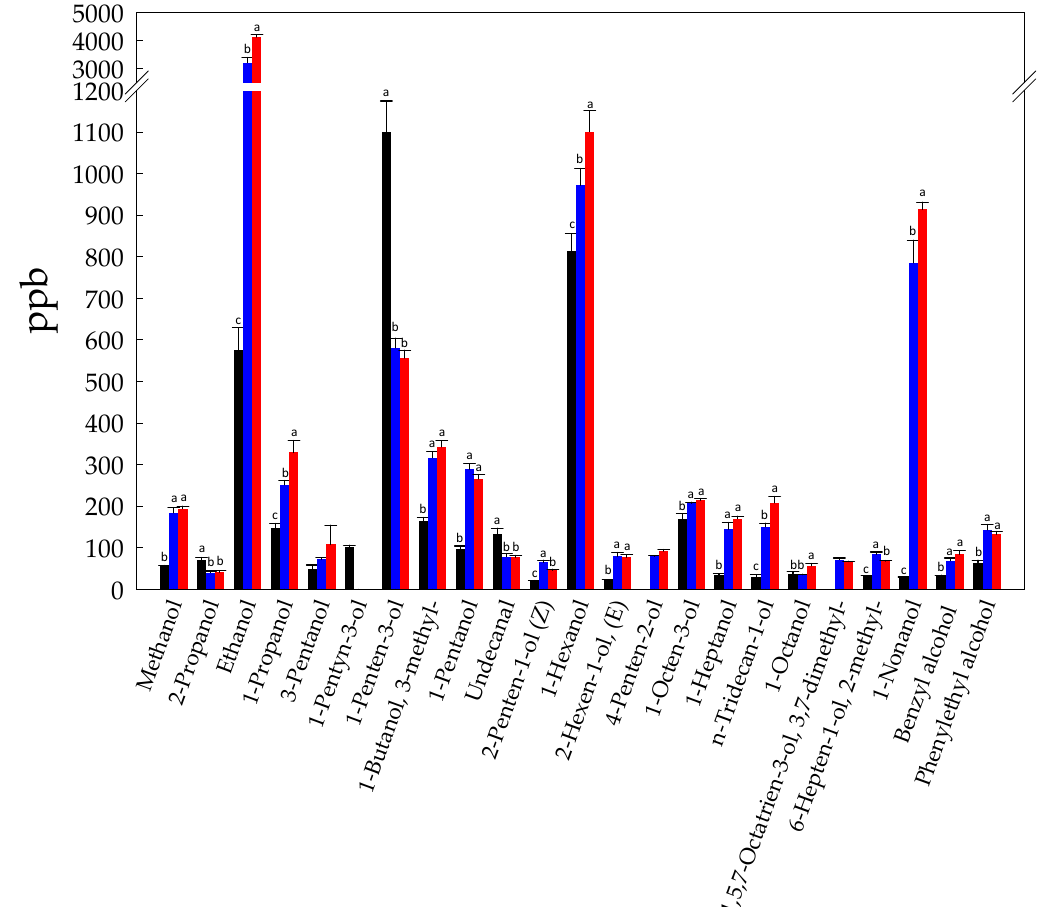
Figure 4. Concentration (ppb) of alcohols identified in Raw- (black bars), Unstarted- (blue bars), and Started-BCP (red bars). Data are the means ( ± SD) of three independent experiments analyzed in triplicate. Data were subjected to one-way ANOVA; pair-comparison of treatment means was achieved by Tukey’s procedure at p < 0.05. For each compound, bars with different superscript letters differ significantly ( p < 0.05).